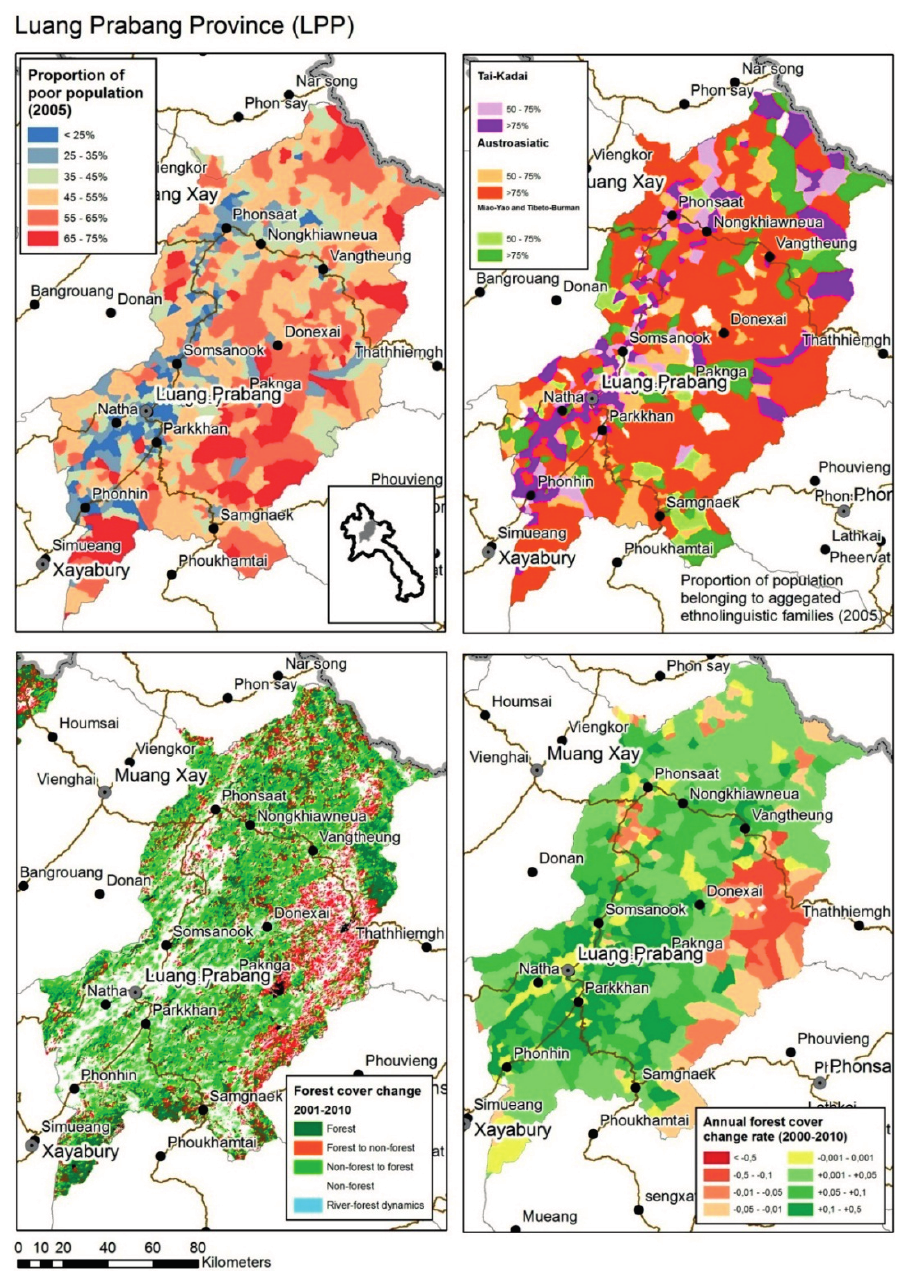
Figure 7. Poverty, ethnic groups and forest cover change in the Luang Prabang